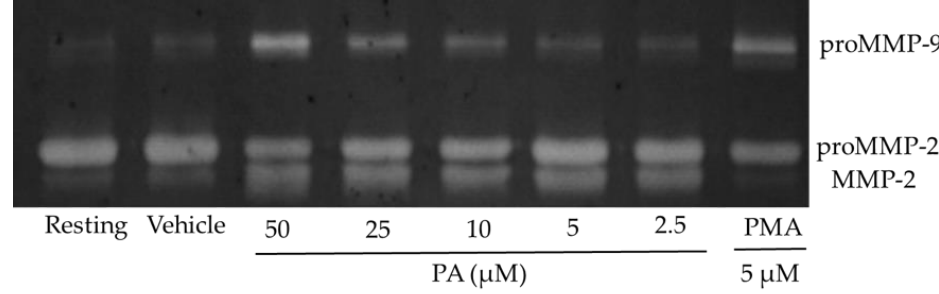
Figure 5. Effects of PA at various concentration. Table 1. MMP-2 and MMP-9 activation by PA at various concentrations.